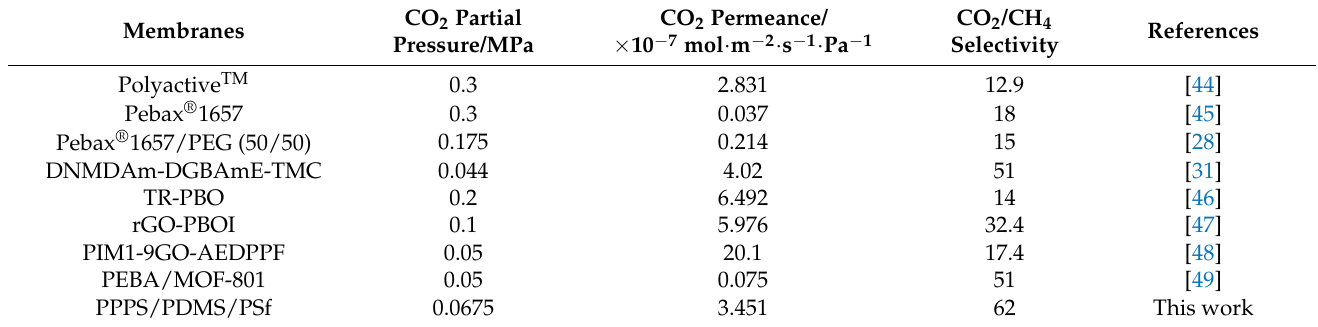
Table 1. Performance comparison with other commercial and reported membranes.